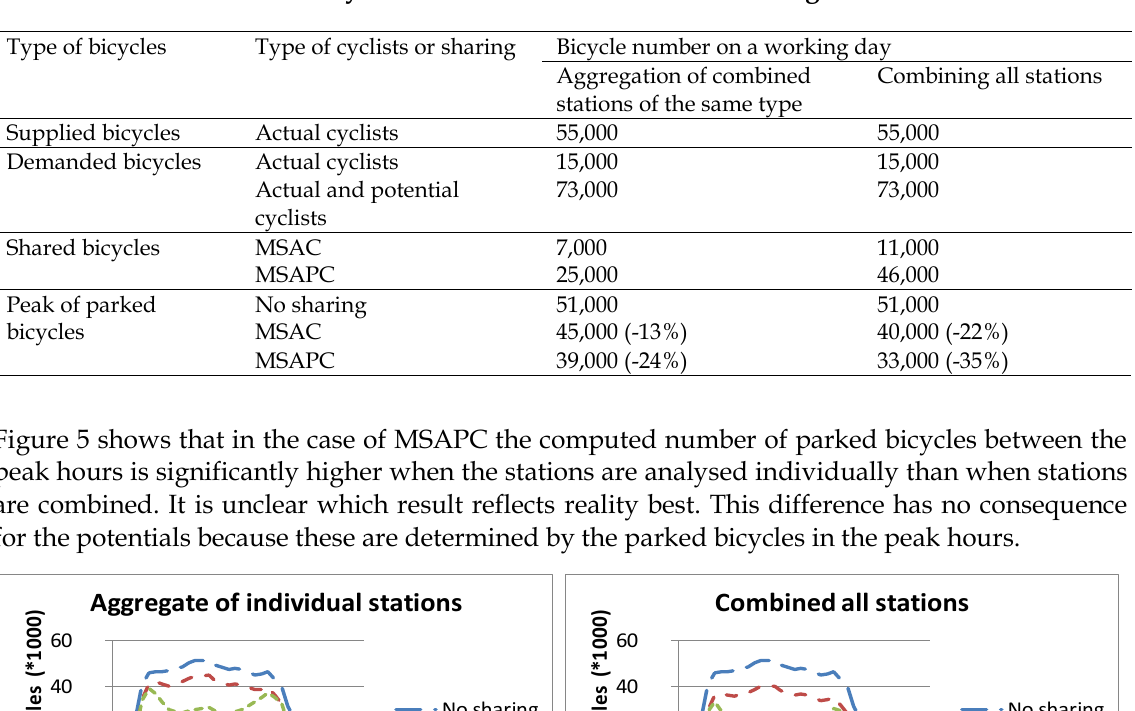
Number of bicycles at the central stations of other large cities